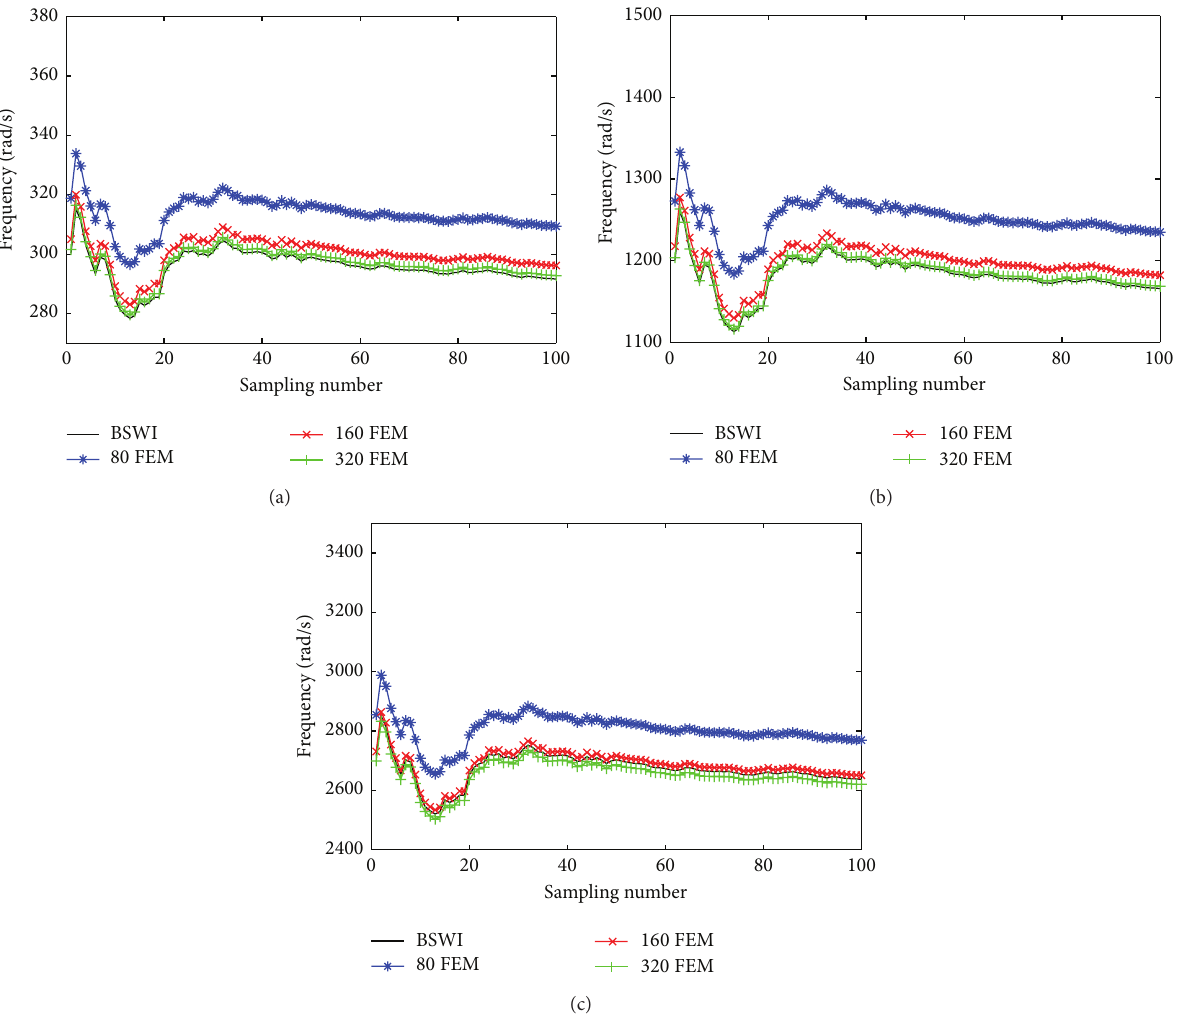
Figure 8: Relationship between the first three natural frequencies and sampling numbers of the Timoshenko beam. (a) First-order circular frequency, (b) second-order circular frequency, and (c) third-order circular frequency.